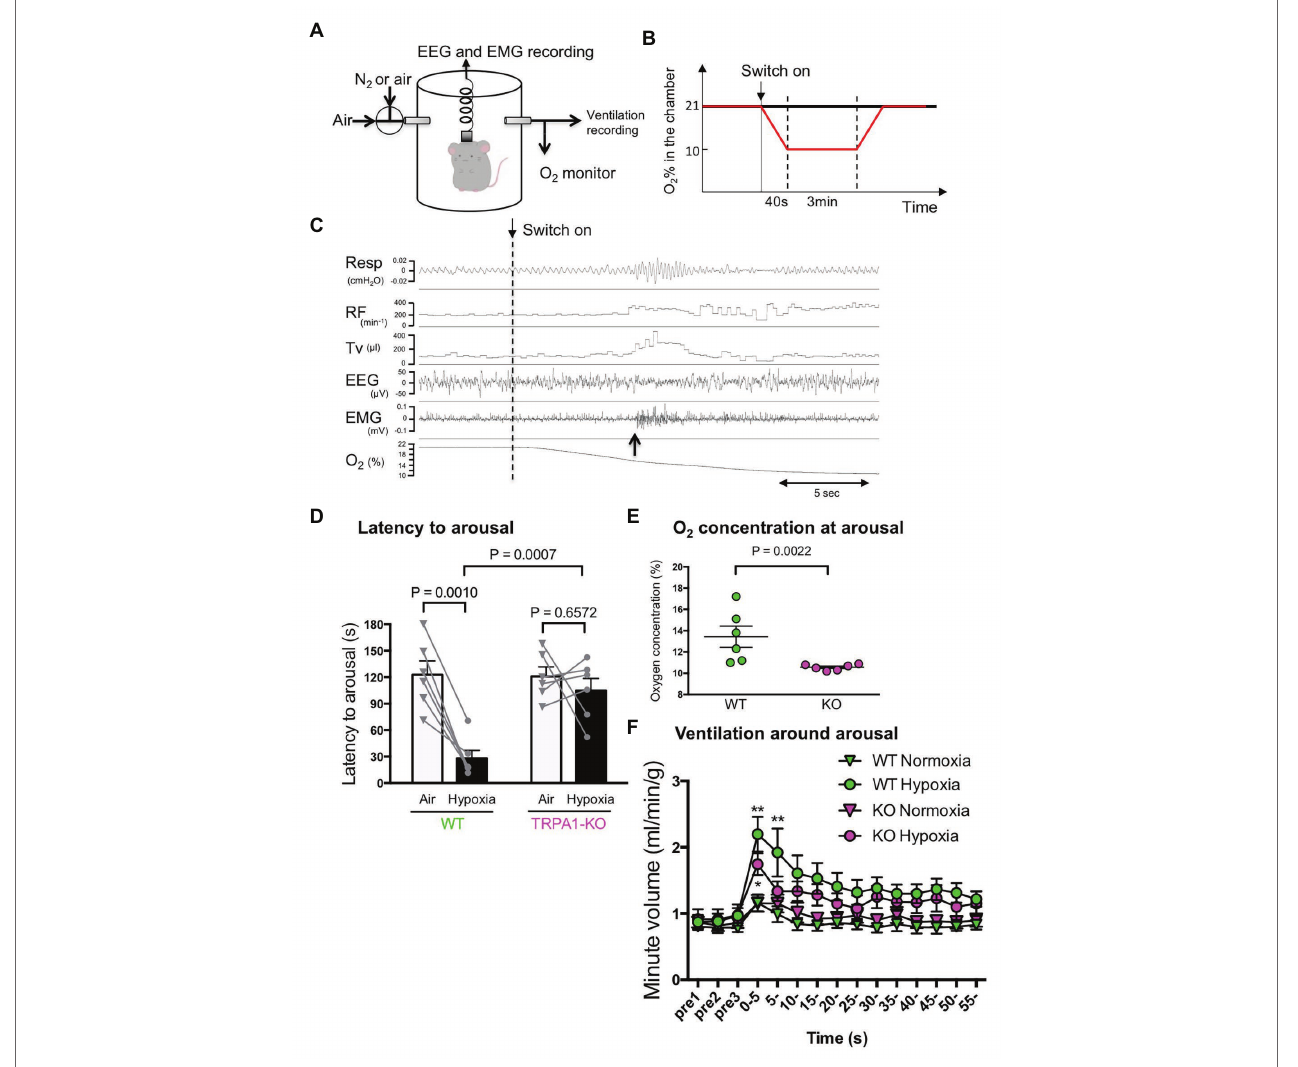
FIGURE 3 | Hypoxia-induced wakeup test. (A) Simultaneous measurement of EEG, EMG, and ventilation by whole body plethysmography. Continuous measurement was obtained using flow-through type body plethysmography. (B) Experimental schedule used to apply hypoxia to mice. (C) Typical recording from a WT mouse showing ventilatory parameters (RF, respiratory frequency; TV, tidal volume), electrophysiological measures, and O 2 concentration in the chamber. The dashed vertical line shows the timing when the inflow was changed from room air to hypoxic (10% O 2 ) gas. The upward arrow shows the timing when the mouse woke up as judged by EEG and EMG. Note that the increase in ventilation was not associated with the start of hypoxia but with the timing of arousal. (D) Latency to arousal from the time of inflow change. The bar indicates mean and SEM, n = 6 for both WT and KO mice. Two-way ANOVA revealed a significant difference between genotypes ( F 1,10 = 9.851, p = 0.0105) and between gas conditions ( F 1, 10 = 17.24, p = 0.0020). Values of p from Sidak’s multiple comparison test are shown. (E)